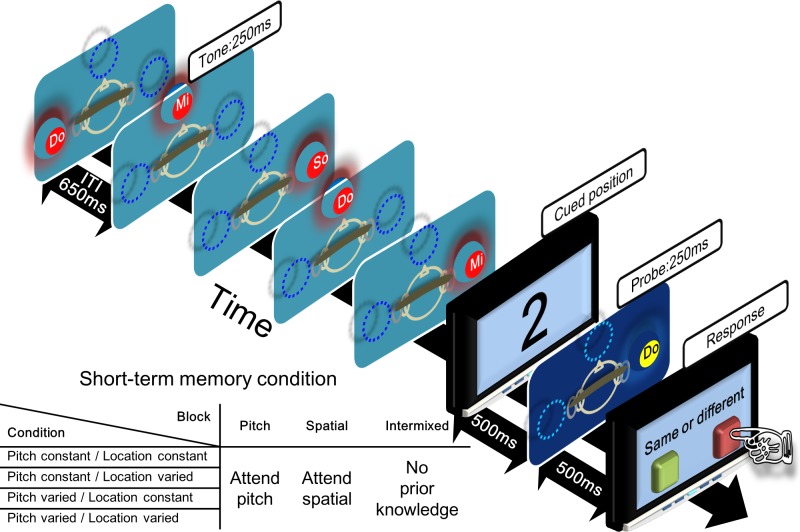
Schematic diagram of pitch and location probed recall working memory task.The sequence consisted of five 250ms musical tones with 650ms ITI. Cued position indicates the number-cued item in the sequence to be compared with the probe tone. Participants indicate whether the cued tone was the same or different with the probe with respect to the indicated feature (i.e., pitch, spatial).